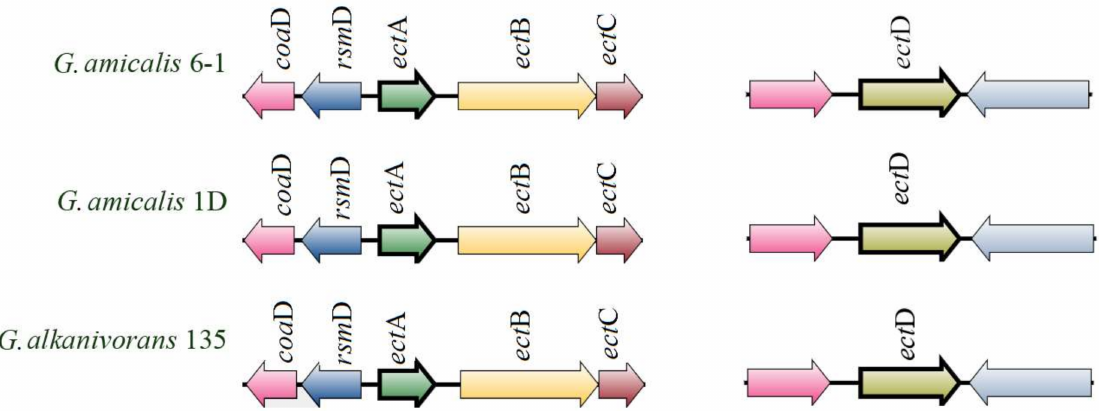
Figure 6. Genomic regions containing ectoine biosynthesis genes in Gordonia strains 6-1, 1D, and